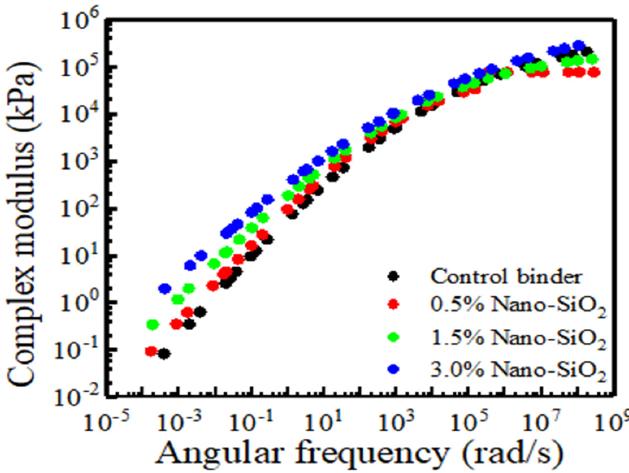
Figure 7. Master curve of complex modulus of TB rubberized asphalt binder.